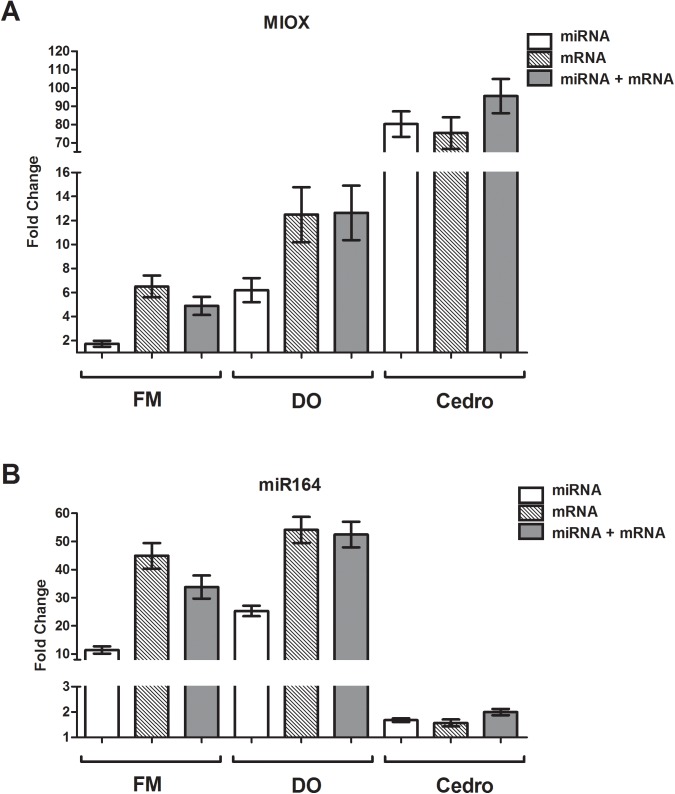
Validation of selected RGs by the relative expression of Gh-MIOX and Gh-miR164 in flowers of three distinct cotton cultivars [FiberMax966 (FM), Delta Opal (DO), and Cedro].The relative quantitative values of A—MIOX and B—miR164 transcripts were obtained by scaling to leaves samples and the normalization was done using reference genes sets of miRNAs: miR172, miR168, and miR390, mRNAs: GhACT, GhPP2A, and GhEF, and miRNA and mRNA: GhACT, GhPP2A, and miR172. The gene expression was analyzed using the 2-ΔΔCt method and statistical tests were calculated using two-way ANOVA. All the relative expression values showed significant differences (p<0.001) between the expression level in flowers and leaves biological pairs, as determined by Bonferroni method, in exception of the GhMIOX transcript in FM (p < 0.05) normalized with miRNAs set.